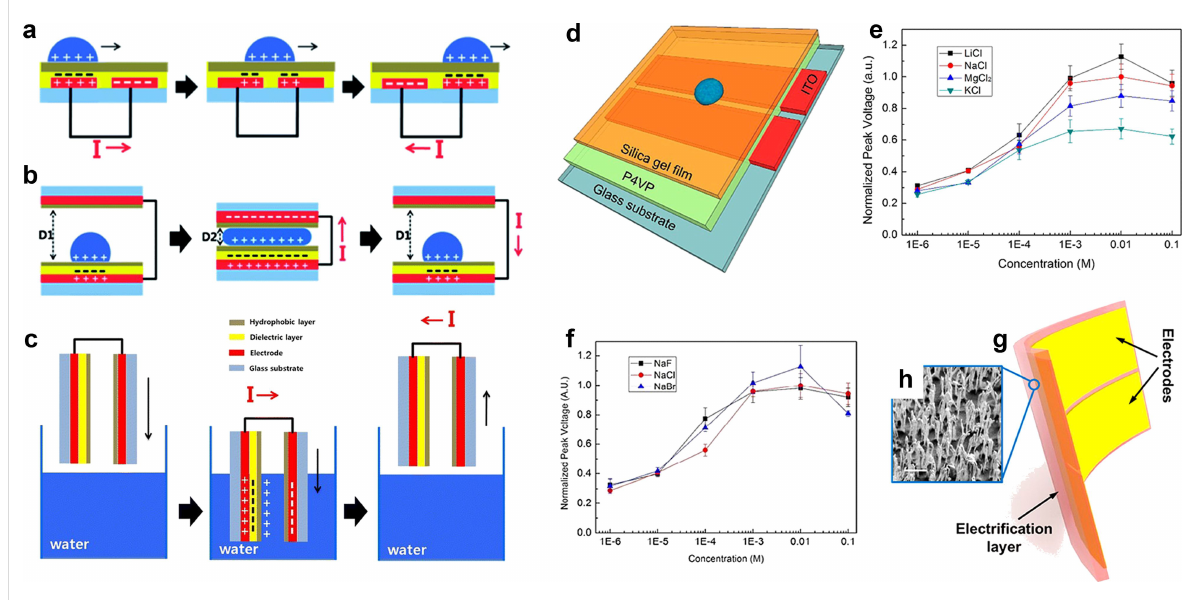
Figure 6: Design and mechanism for (a) flat type, (b) pushing/releasing type, and (c) dipping type (c) of water motion active transducers. Figure 6a–c were republished with permission of The Royal Society of Chemistry from [75] (“An effective energy harvesting method from a natural water motion active transducer” by Kwon, Soon-Hyung et al., Energy Environ. Sci., vol. 7, issue 10, © 2014); permission conveyed through Copyright Clearance Center, Inc. This content is not subject to CC BY 4.0. (d) Schematic image of the F4VP device. (e) Using chloride ions as the fixed anions, various alkali metal ions were used to study the effect of the atomic number of the cation on the output power. (f) Using sodium ions as fixed anions, various alkali halide anions were used to study the effect of the atomic number of the anion on the output power. Figure 6d–f were reprinted with permission from [78], Copyright 2015 American Chemical Society. This content is not subject to CC BY 4.0. (g) Structural design of a FEP device. (h) SEM image of the polymer nanowires on the polymer layer. The scale bar is 1 μ m. Figure 6g and 6h were reprinted with permission from [21], Copyright 2014 American Chemical Society. This content is not subject to CC BY